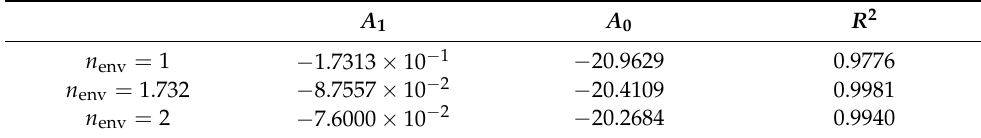
Table 1. Fitting to Equation (12) of the simulation results for several refraction indexes in the